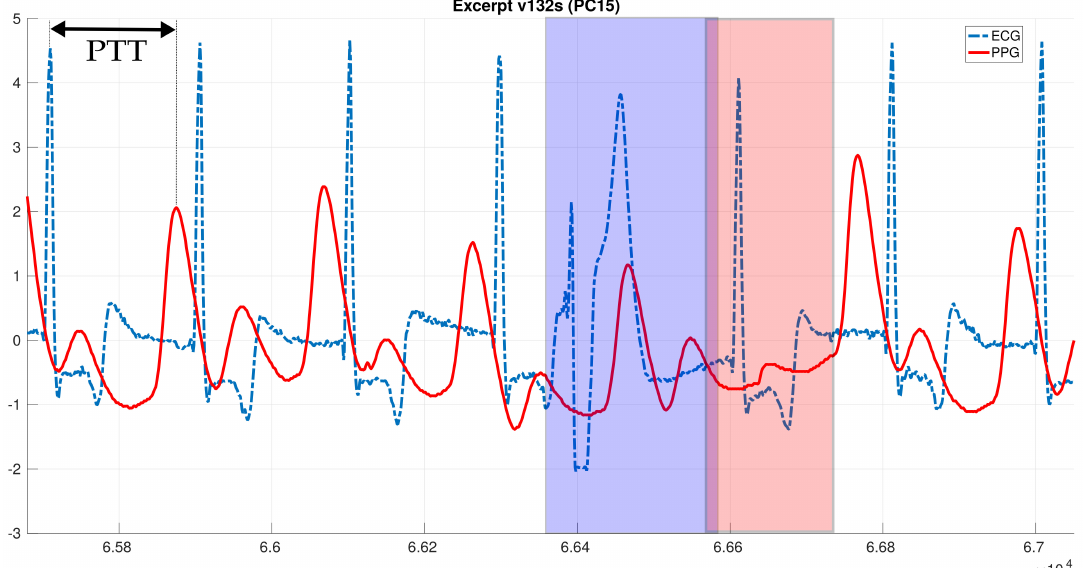
Figure 4. Excerpt of a synchronized recording of ECG (blue dash-dotted) and PPG (red solid) containing a single ectopic beat, highlighted with blue and red backgrounds respectively. Note the shift between the R-peak of the ECG and the respective pulse peak of the PPG, known as Pulse Transit Time